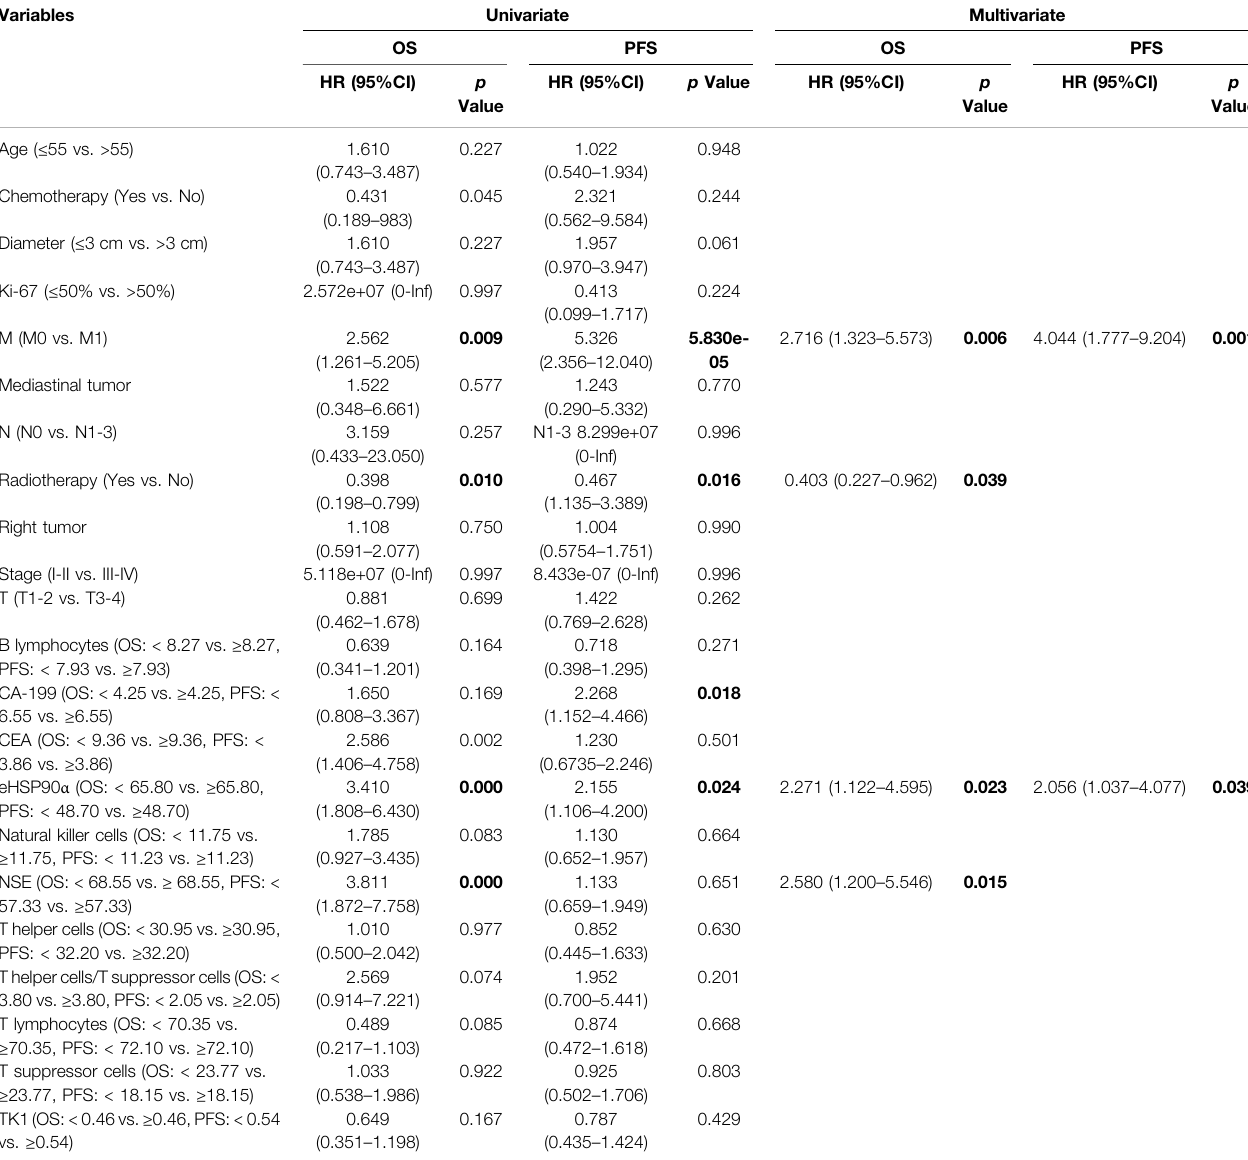
TABLE 5 | Univariate and multivariate cox proportional regression analysis of OS and PFS in SCLC. Variables Univariate